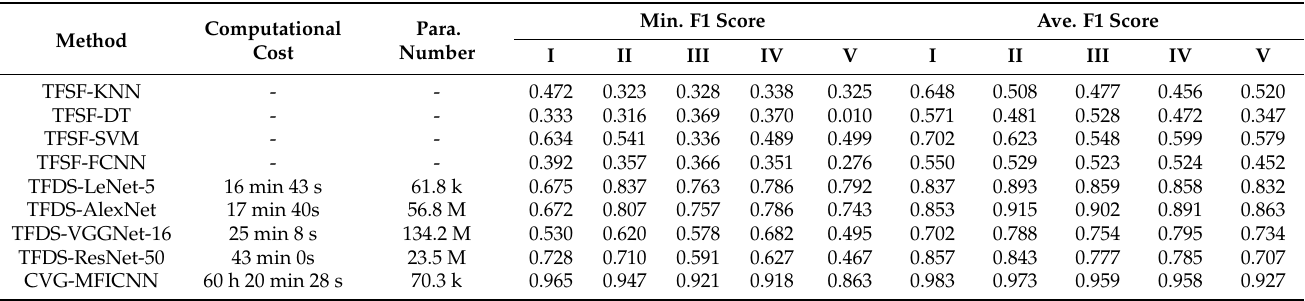
Table 7. Performance comparison of traditional ML and classical CNN